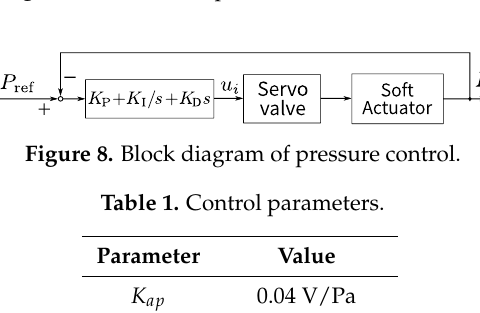
Figure 7. Fabrication process of the soft actuator.